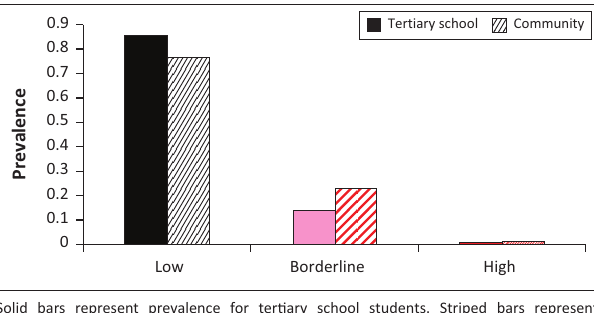
Solid bars represent prevalence for tertiary school students. Striped bars represent prevalence for community youth. Black bars = low autistic traits (L-AUT) with scores of 32 or higher (on the autism spectrum quotient). Dark grey bars = borderline autistic traits (B-AUT) with scores of 26–31. Light grey bars = high autistic traits (H-AUT) with scores of 25 or lower. FIGURE 2: Prevalence of autistic trait categories in tertiary school students and community youth.